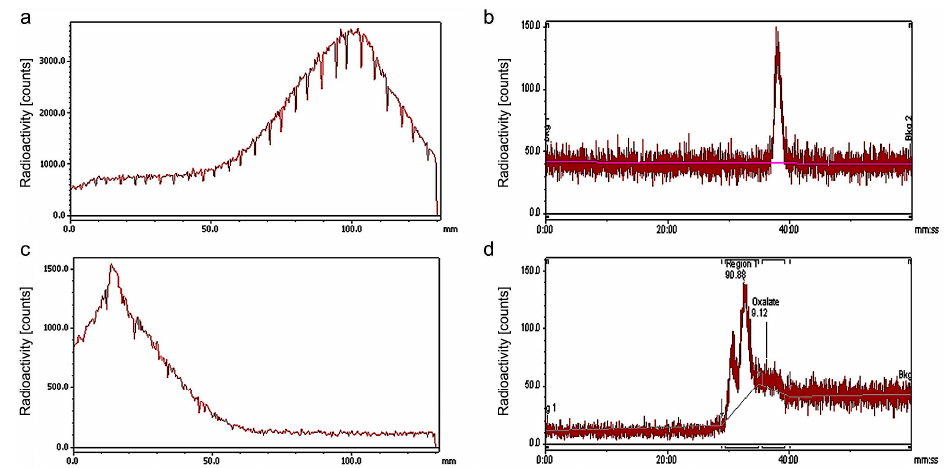
Figure 2. 89 Zr uptake by Hb-DFO: Radiochromatography analysis. Radio-TLC ( a ) and radio-HPLC ( b ) chromatograms of control 89 Zr oxalate are reported; ( c ) and ( d ) show the radio-TLC and radio-HPLC chromatograms of Hb-DFO- 89 Zr, respectively. Radio-TLC analysis does not allow detection of zirconium oxalate signal, while in more sensitive radio-HPLC measurement only a low peak was observed. As the resolution of radio-HPLC chromatogram is higher than radio-TLC, two peaks for Hb-DFO- 89 Zr are observed, that indicates the presence of Hb aggregates in the product (reflected by the initial, lower